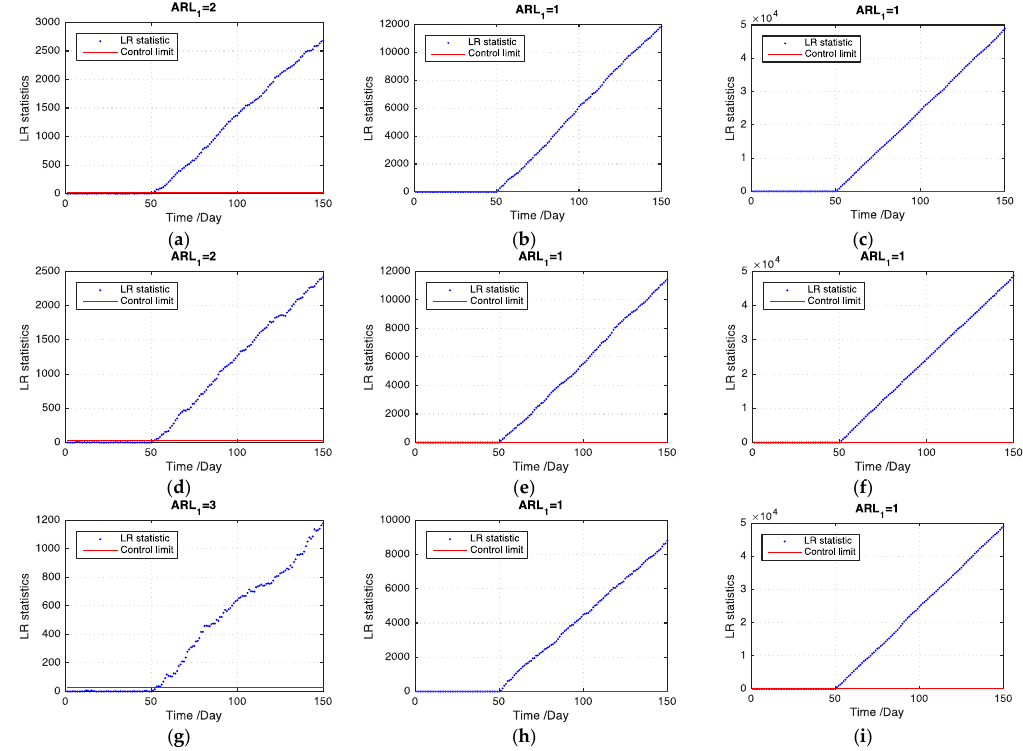
Figure 5. LR statistics using the proposed model for detecting the medium outbreak cluster. (Note: the ranges of the Y -axis in each graph are substantially different.). ( a ) shift magnitude = 0.5, 20% missing values; ( b ) shift magnitude = 1, 20% missing values; ( c ) shift magnitude = 2, 20% missing values; ( d ) shift magnitude = 0.5, 30% missing values; ( e ) shift magnitude = 1, 30% missing values; ( f ) shift magnitude = 2, 30% missing values; ( g ) shift magnitude = 0.5, 50% missing values; ( h ) shift magnitude = 1, 50% missing values; ( i ) shift magnitude = 2, 50% missing values.